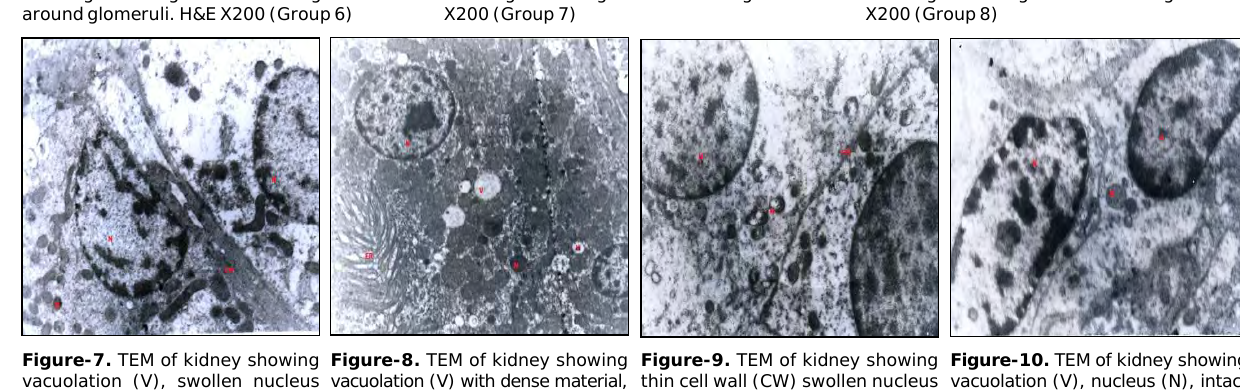
Figure-8. TEM of kidney showing vacuolation (V) with dense material, swollen nucleus (N), margination of chromatin and irregular mitochondria (M). (Group 7) 3440X